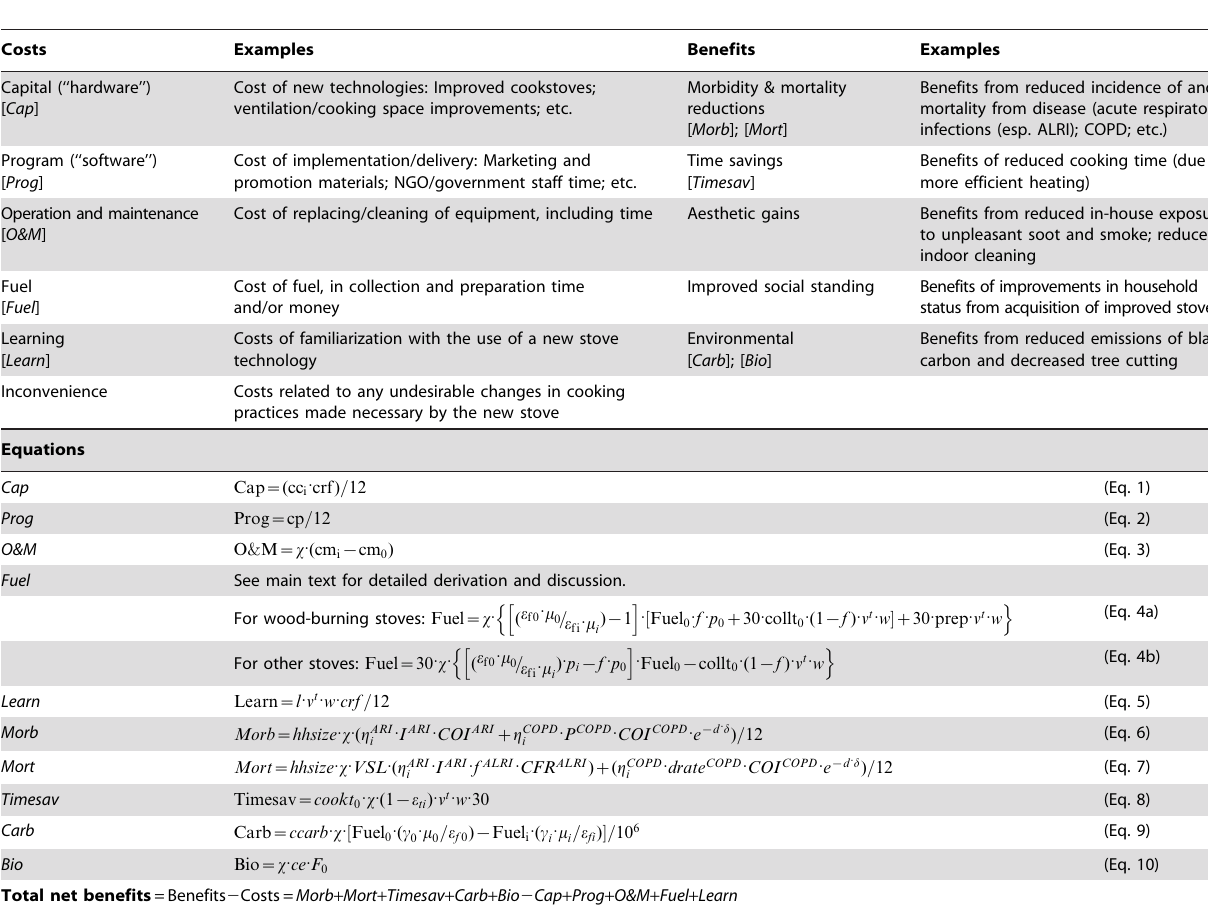
Table 1. Typology of costs and benefits of improved cookstoves, and equations used for calculations.